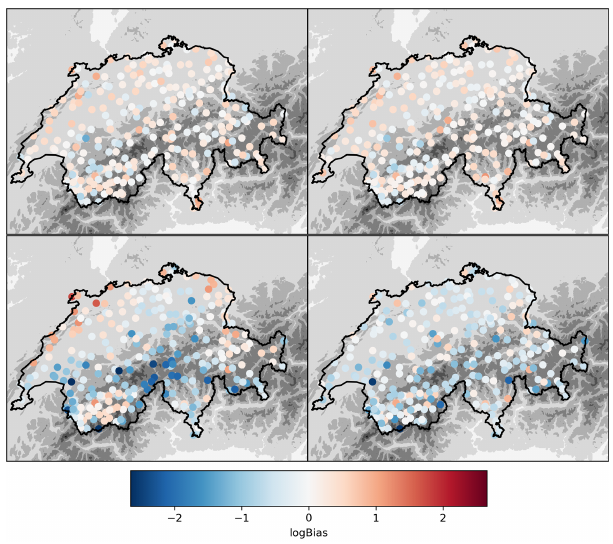
Figure 10. Cross-validation logBias at every ground station for RF_dualpol, RF_hpol, RZC and CPC.CV. The displayed geograph- ical domain is the same as in Fig. 1. The gray colors in the back- ground illustrate the topography.